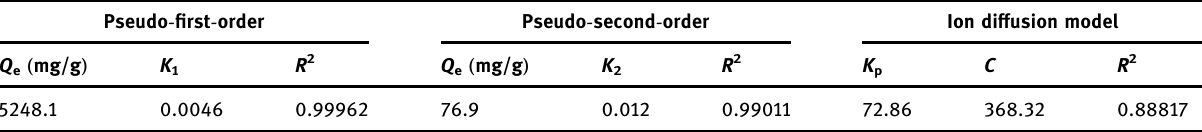
Table 2: Linear fi tting parameters of adsorption kinetics of Ni ( II )- IIP 5 Pseudo - fi rst - order